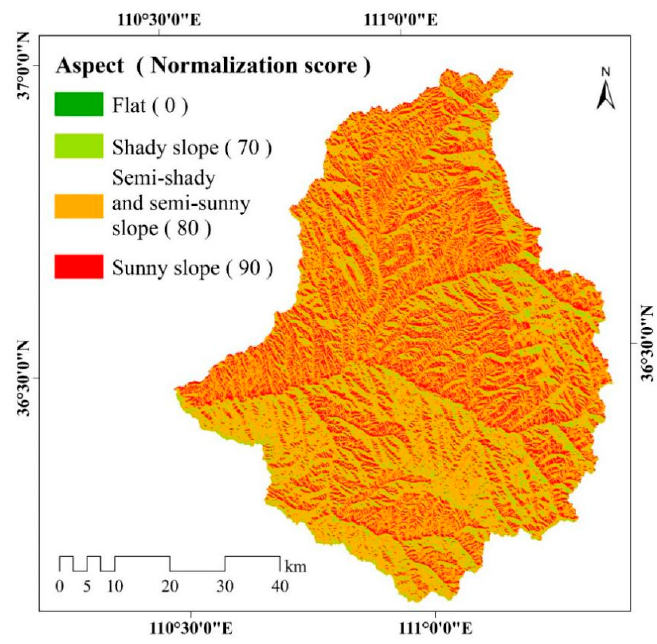
Figure 7. Spatial distribution of slope aspect in the study area. The different colors represent different slope aspects, including flat, shady slope, semi-shady and semi-sunny slope, sunny slope. A higher normalization score of the slope aspect represents a greater impact on soil erosion.